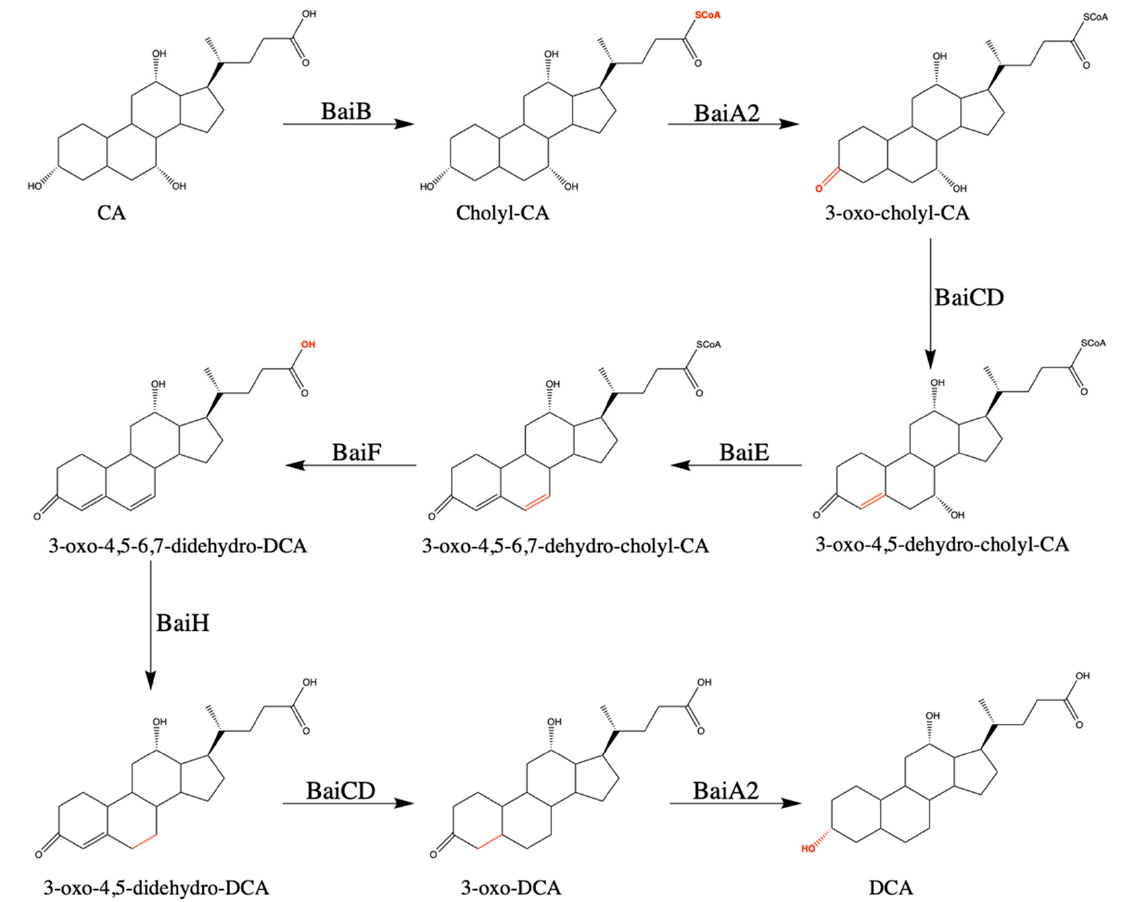
Figure 2. Proposed pathway for conversion from CA to DCA via 7 α -dehydroxylation. This metabolic pathway converts CA to DCA or converts CDCA to LCA in eight steps. Abb. BaiB, bile acid-coenzyme A ligase; BaiA2, 3 α -hydroxysteroid dehydrogenase; BaiCD, 7 α -hydroxy-3-oxo- ∆ 4 -cholenoic acid oxidoreductase; BaiE, bile acid 7 α -dehydratase; BaiF, bile acid coenzyme A transferase/hydrolase; BaiH, 7 β -hydroxy-3-oxo- ∆ 4 -cholenoic acid oxidoreductase; CA, cholate; DCA, de ‐ oxycholate.